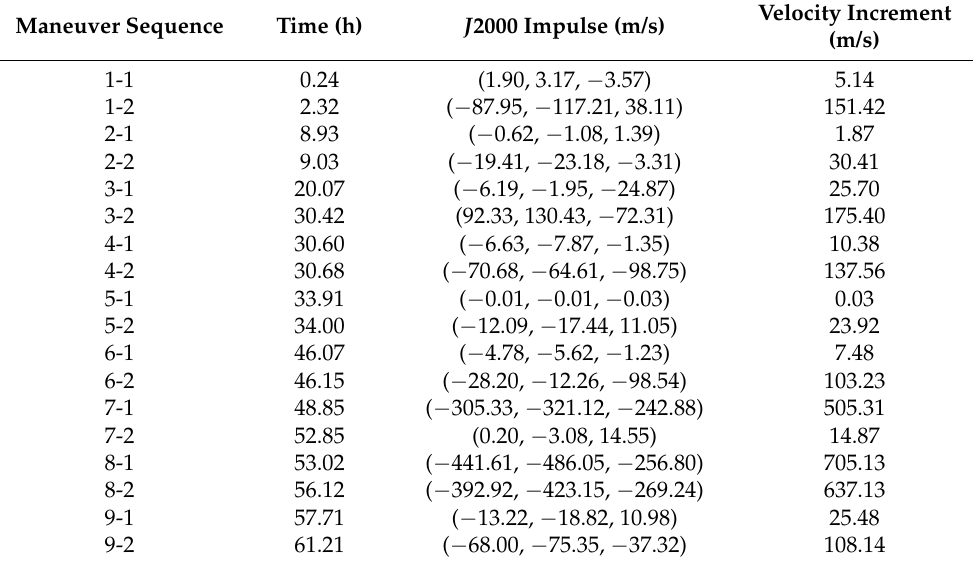
Table 5. Orbit maneuver